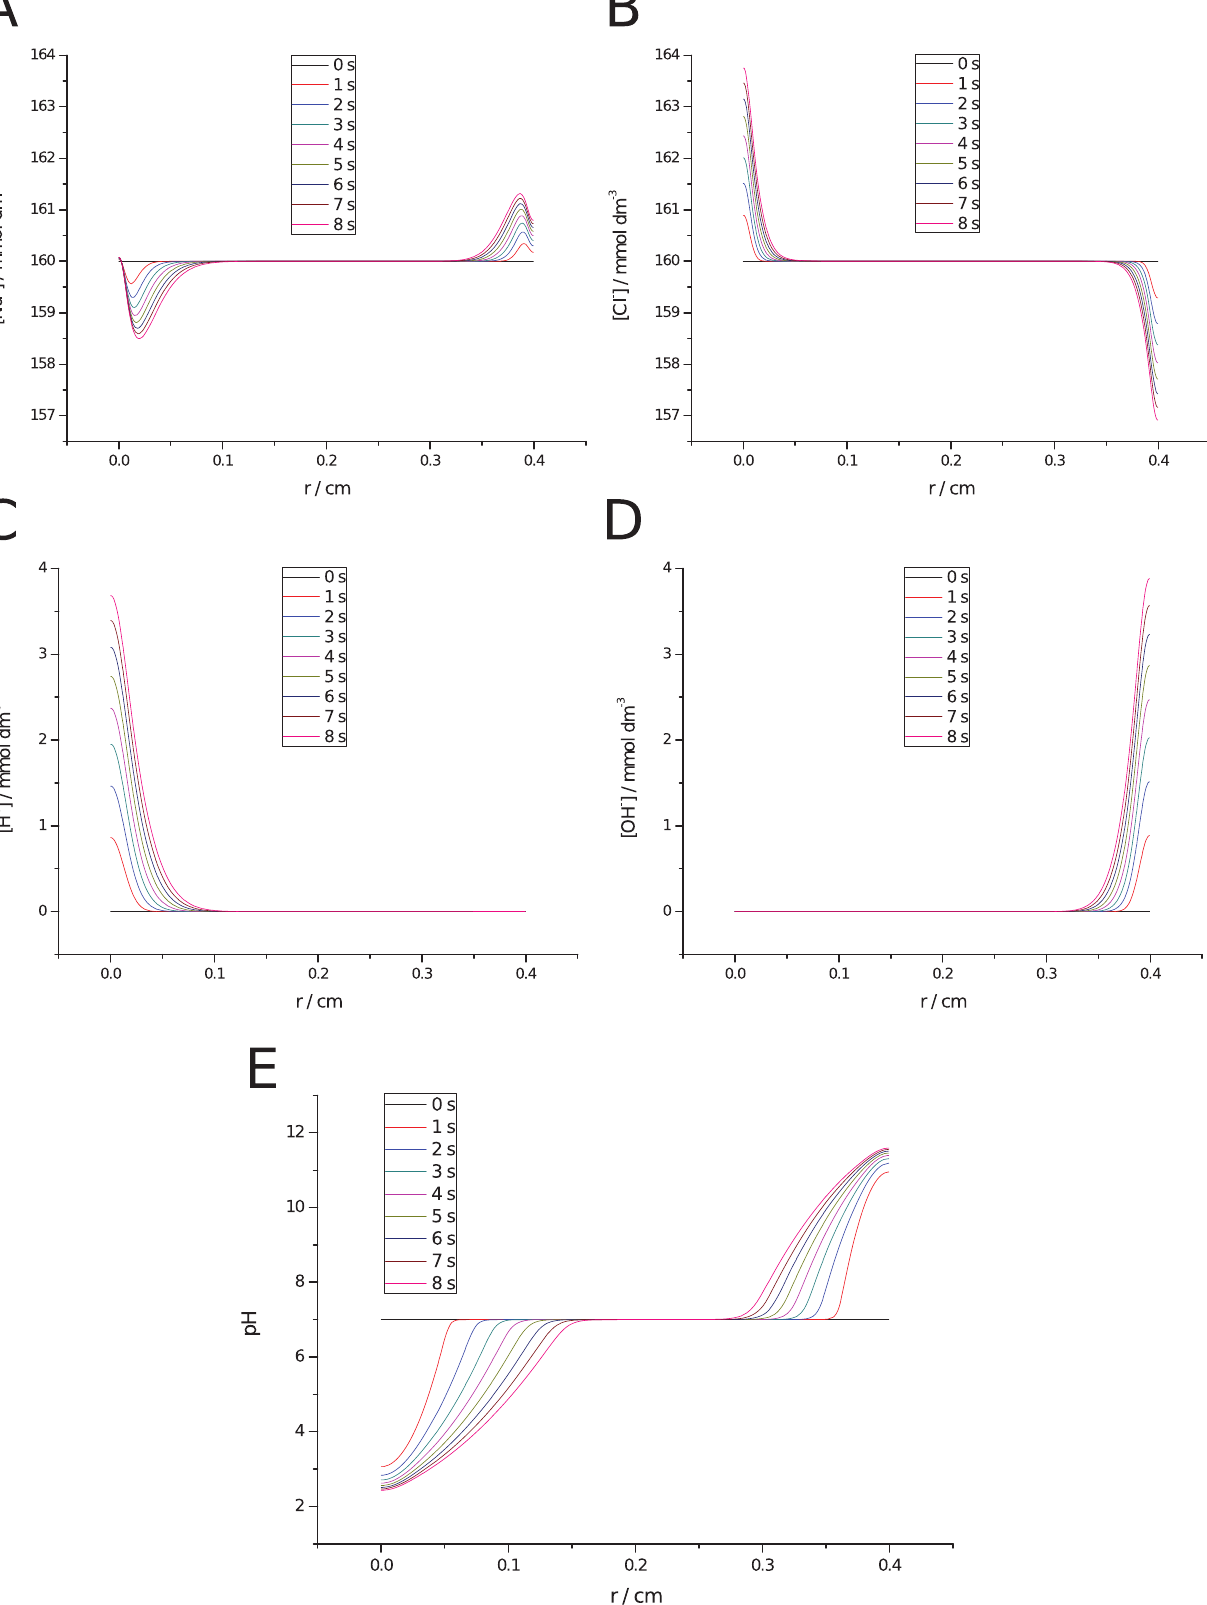
Figure 5. Predicted ionic concentration and pH variation during ECT. Ionic concentrations ( mmol = dm 3 ) and pH distribution in space (cm), (8 pulses of 400 V and 100 m s at 1 Hz ) at different times (0–8 s). Anode at left and cathode at right: a) Sodium, b) Chlorine, c) Protons, d) Hydroxides, and e) pH distribution. doi:10.1371/journal.pone.0017303.g005 PLoS ONE |